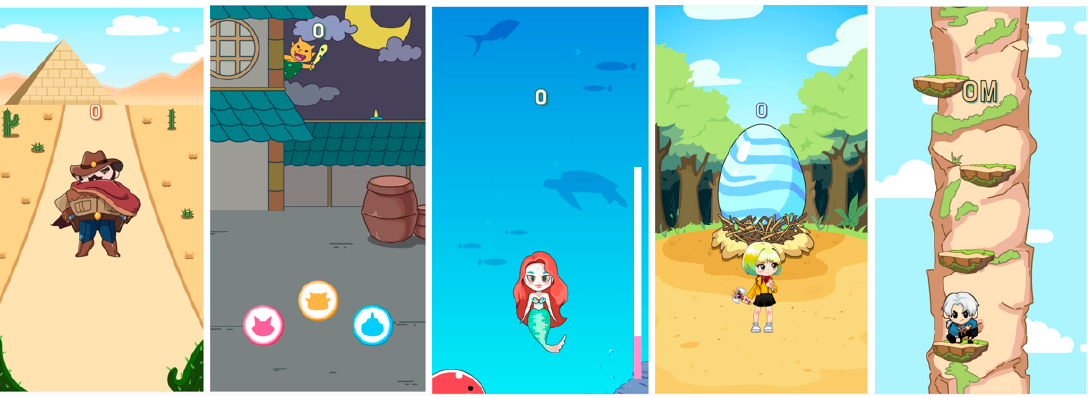
Figure 2. Super Kids Adventure home exercise game.